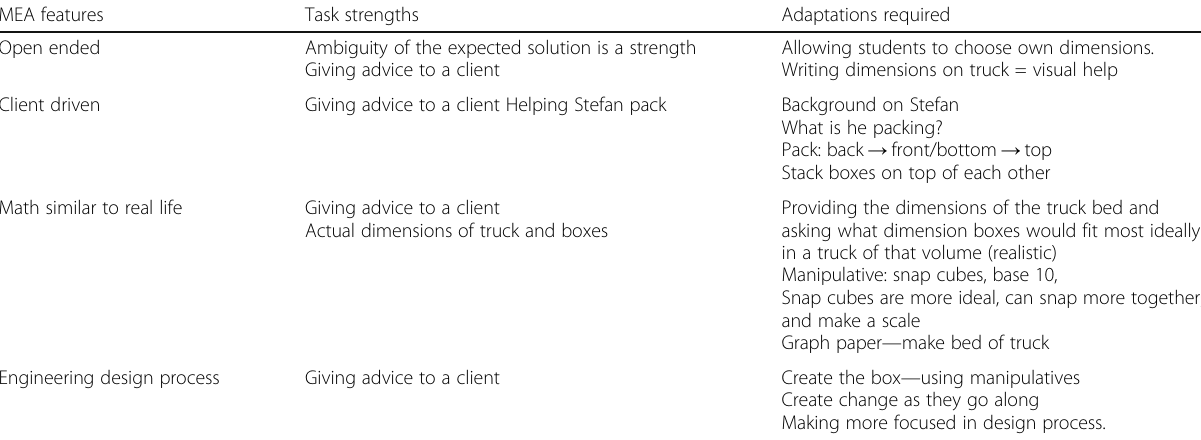
Table 1 Completed task adaptation chart for the “ Packing It In ” task MEA